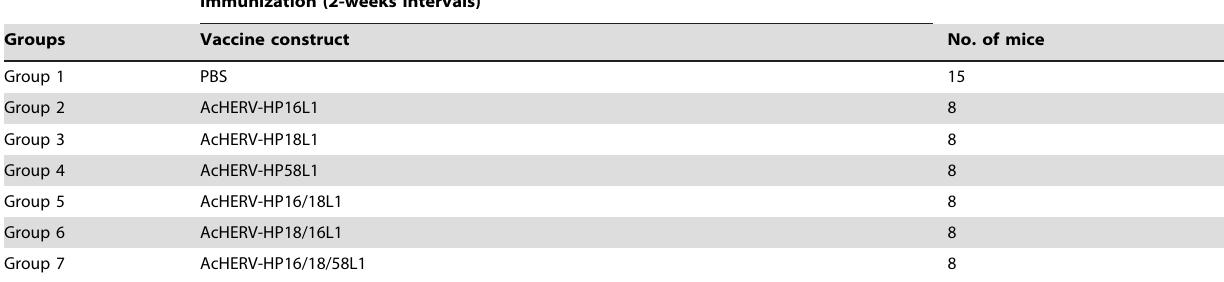
Table 1. Immunization